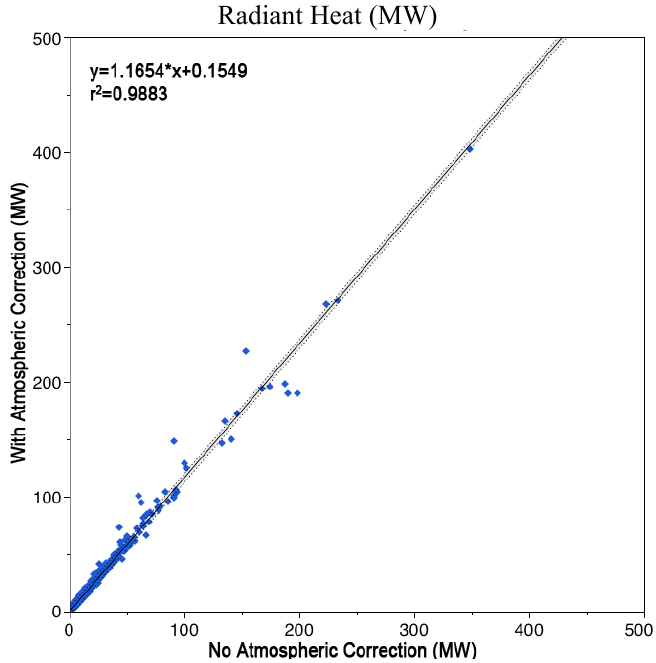
Figure 11. Plot of local maxima radiant heat estimates with and without atmospheric correction from 4 April 2013. The shaded area encompasses the 99% confidence interval around the regression line.